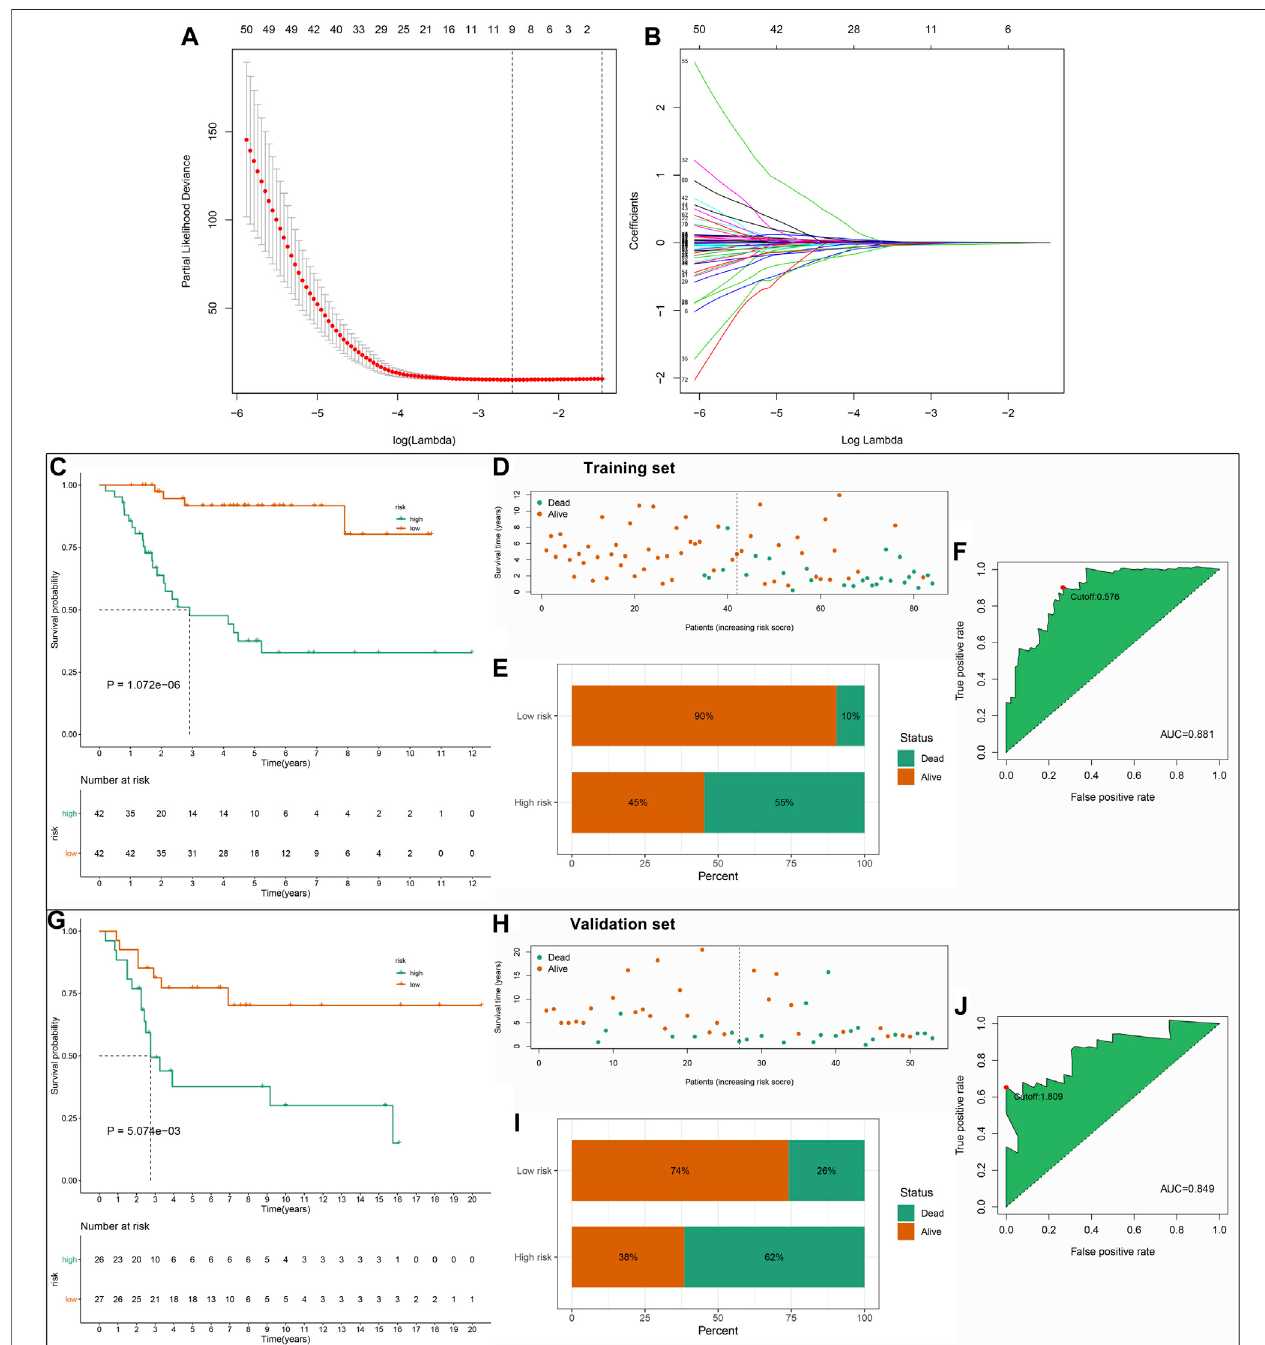
FIGURE 3 | Establishment and veri fi cation of a stromal – immune score-based prognostic gene signature for osteosarcoma. (A) A 10-fold cross-veri fi cation for determining the number of factors. (B) Least absolute shrinkage and selection operator (LASSO) coef fi cient pro fi les of stromal – immune score-based gene features. (C) Kaplan – Meier curves of OS between high- and low-risk groups in the TARGET dataset. (D,E) The distribution and proportion of survival status in the high- and low-risk groups. The dotted line indicates the median value of risk scores. (F) Receiver operating characteristic (ROC) of OS time based on the risk scores in the TARGET dataset.Themaximumin fl ectionpointwasthecut-offpointbytheAkaikeinformationcriterion(AIC). (G) Kaplan – MeiercurvesofOSbetweenhigh-andlow-riskgroupsin the GSE21257 dataset. (H,I) The distribution and proportion of survival status of high- and low-risk osteosarcoma patients. (J) ROC of OS time for validating the predictive ef fi cacy of this signature in the GSE21257 dataset.